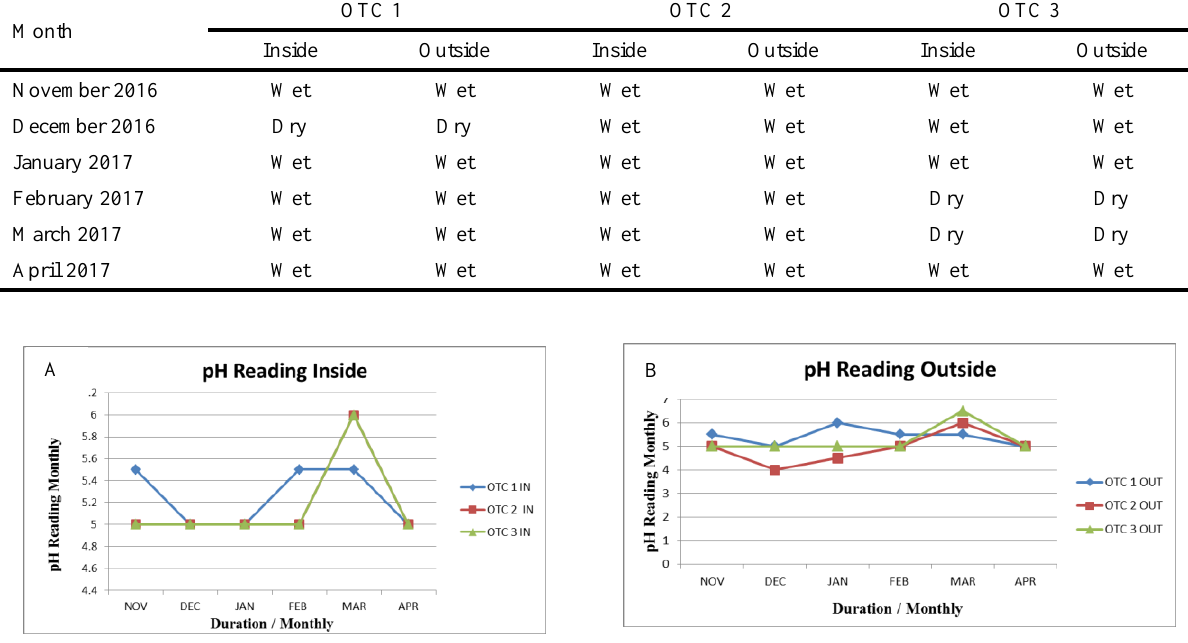
Figure 2: pH of the soil (A) soil’s pH inside the OTC of 3 Different Units from November 2016 to April 2017 and (B) soil’s pH outside the OTC of 3 Different Units from November 2016 to April 2017